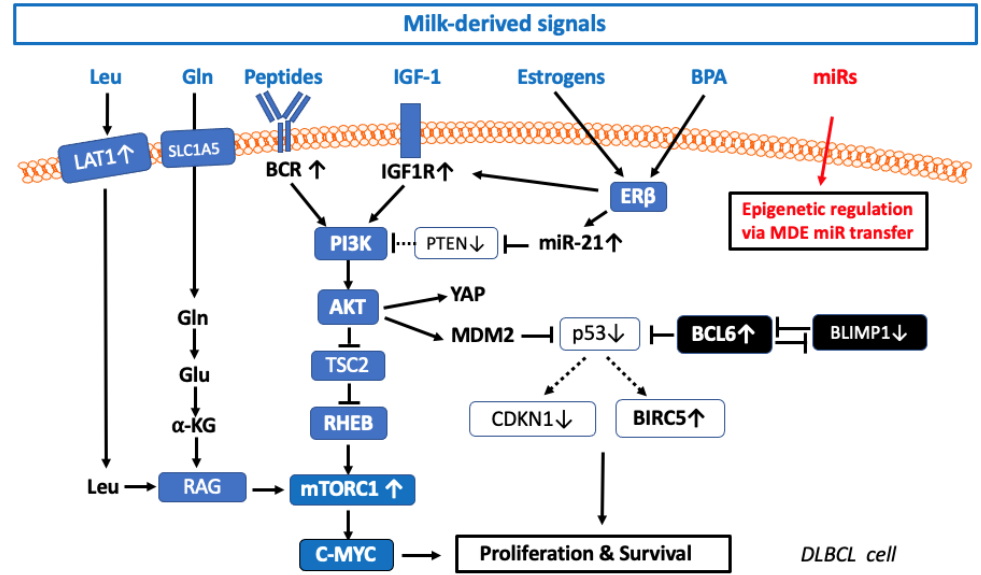
Figure 1. Potential synergism of milk-induced phosphatidylinositol-3-kinase (PI3K)-AKT-mechanistic target of rapamycin complex 1 (mTORC1) signaling and overstimulated PI3K-AKT-mTORC1 signaling in diffuse large B-cell lymphoma (DLBCL). B-cell receptor (BCR) is commonly activated in DLBCL and stimulates the mTORC1 pathway. Milk-derived peptides are known agents interacting with BCR. Insulin-like growth factor 1 (IGF-1)/IGF-1 receptor (IGF1R) signaling is also activated in DLBCL. Milk contains IGF-1 and stimulates IGF-1 synthesis in human milk consumers. IGF-1/IGF1R signaling activates mTORC1. Expression or function of phosphatase and tensin homolog (PTEN) is commonly suppressed in DLBCL and is also targeted by microRNAs (miRs), especially miR-21. DLBCL cells frequently overexpress L-type amino acid transporter 1 (LAT1), which plays a crucial role in intracellular uptake of leucine (Leu), which via Ragulator (RAG) activates mTORC1. Leu is an abundant amino acid of milk proteins. Glutamine (Gln) is also enriched in milk proteins. The glutaminolysis pathway is activated in DLBCL cells. The end product α-ketoglutarate (αKG) via RAG as well activates mTORC1, which finally promotes the translation of the oncogene C-MYC, the key driver of cell proliferation. The activated kinase AKT stimulates YES1-associated transcriptional regulator (YES) of the HIPPO pathway found to be activated in DLBCL. Estrogen receptor β (ERβ) was also found to be overexpressed in subtypes DLBCLs. ERβ induces the expression of IGF1R and miR-21-5p. Milk-derived estrogens and milk contamination with bisphenol A (BPA) may contribute to ERβ signaling in DLBCL. AKT-mediated activation of mouse double minute 2 (MDM2) promotes the proteasomal degradation of p53, the guardian of the genome. p53 regulates the transcription of cyclin-dependent kinase inhibitor 1A ( CDKN1A ; p21) and of the anti-apoptotic protein survivin ( BIRC5 ). TP53 is frequently downregulated in DLBCL. The oncogene B cell lymphoma 6 (BCL6) is commonly upregulated in DLBCL and functions as a negative regulator of both p53 and B lympho- cyte-induced maturation protein 1 (BLIMP1, PRDM1 ). As such, milk-derived exosomal microRNAs play a key role in epigenetic regulation. 3.7. Viral Agents in DLBCL Viral agents are regarded as potential drivers of DLBCL tumorigenesis [206,207]. Var- ious reports suggest an association of viral infections with DLBCL, including Epstein–Barr virus (EBV) also known as human herpes virus 4 (HHV4) [208–216], human immunode- ficiency virus HIV (HIV) [217–221], hepatitis B virus (HBV) [222–226], hepatitis C virus (HCV) [227–229], human T-cell leukemia virus type 1 (HTLV-1) [230], and Simian virus 40 (SV40) infections [231–233], while human herpes virus 8 (HHV8) also known as Kaposi sarcoma-associated herpesvirus (KSHV) [30,234–236] and human papilloma virus (HPV) [237,238] associations with DLBCL are only rarely observed. EBV-positive DLBCL, not otherwise specified (NOS), is an EBV-positive clonal B cell lymphoid proliferation [239], that plays a major role in all virus-associated DLBCLs [214].